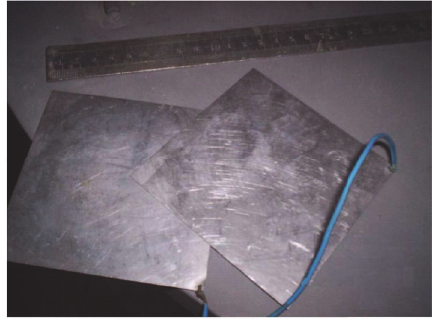
Figure 8: Stainless steel electrodes.